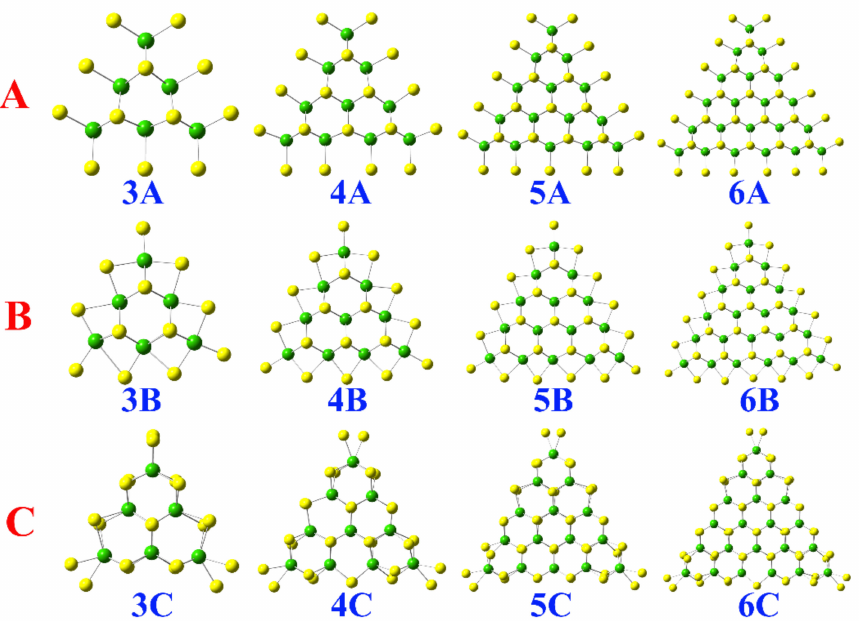
Figure 1. Top view of the triangle MoS 2 clusters with different sizes and edges. The Mo and S atoms are represented by green and yellow spheres, respectively.